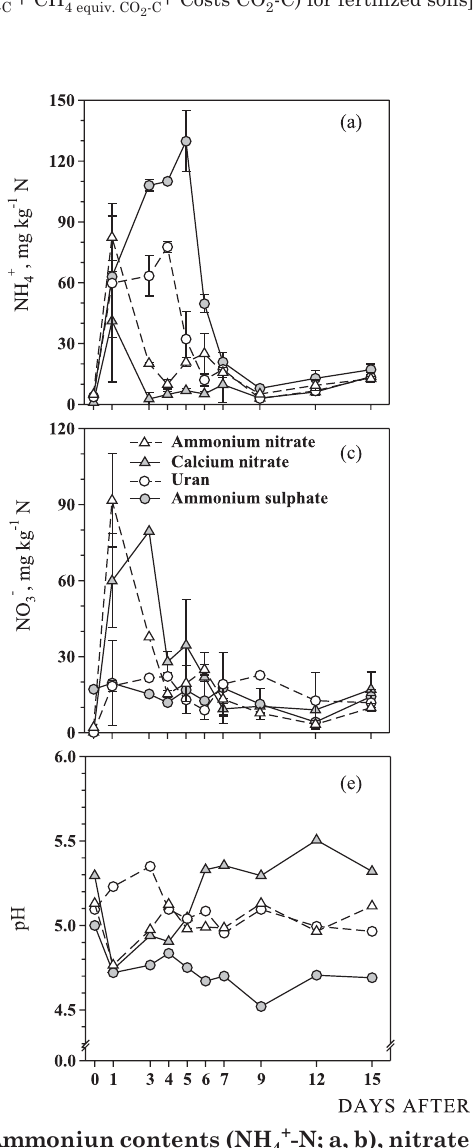
O and CH emissions from soil in the 15 day period after nitrogen fertilizer 2 4 -C, costs in CO -C of the fertilizer and total 2 2 O+CH +custos C-CO ) as a consequence of mineral nitrogen fertilization 2 4 2